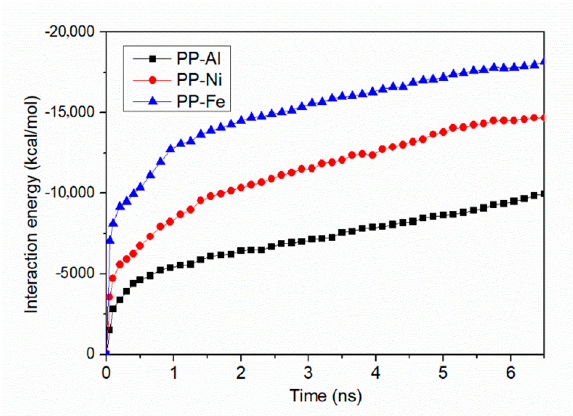
Figure 8. Interaction energies at PP-Al, PP-Ni and PP-Fe interface as a function of simulation time.